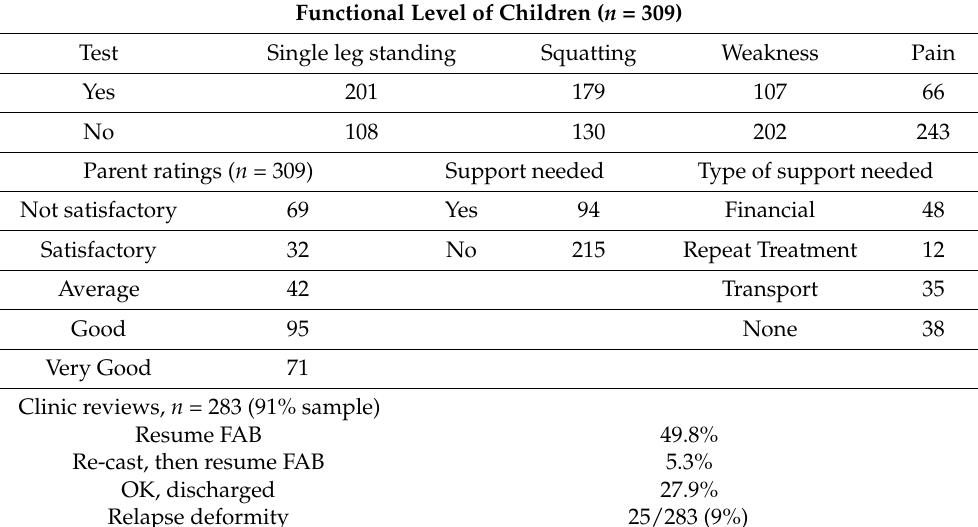
Table 3. Parents’ ratings of clubfoot